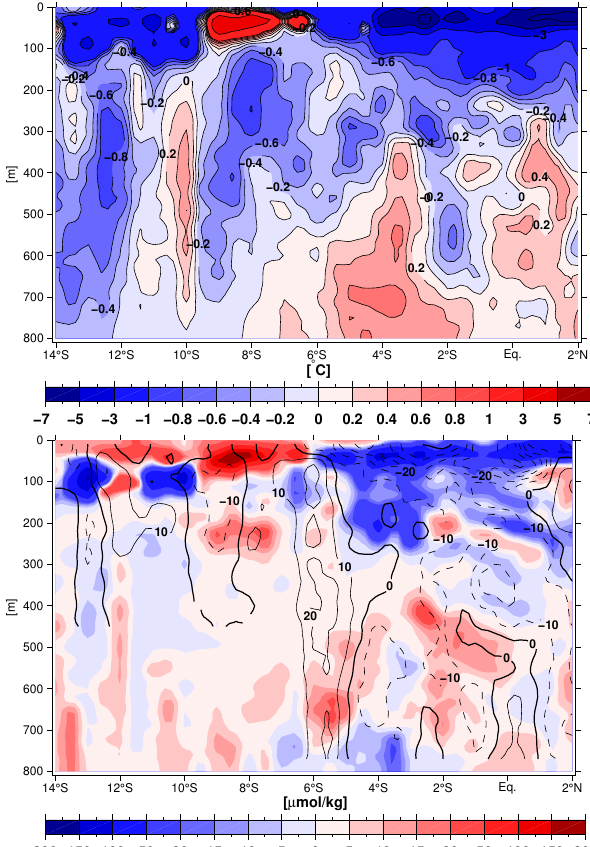
Figure 12. Distribution of differences along 85 ◦ 50 (cid:48) W between February 2009 and March 1993 in (top) potential temperature in ◦ C and (bottom) oxygen in µmolkg − 1 (color) and ADCP measured zonal velocity (black contours; cms − 1 ; positive